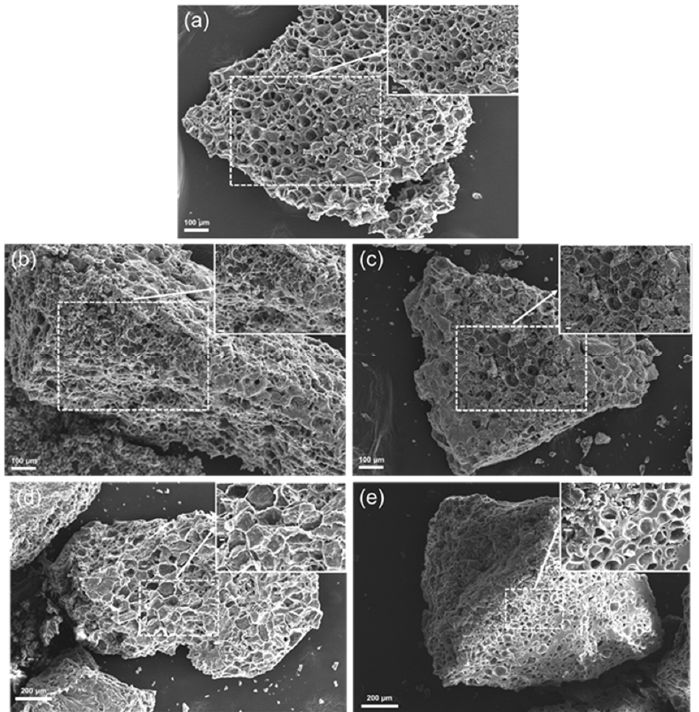
Figure 3. SEM images of avocado seed biochar (AB): ( a ) unmodified AB, ( b ) AB + High Fe, ( c ) AB + Low Fe, ( d ) AB + High Mg, and ( e ) AB + Low Mg.